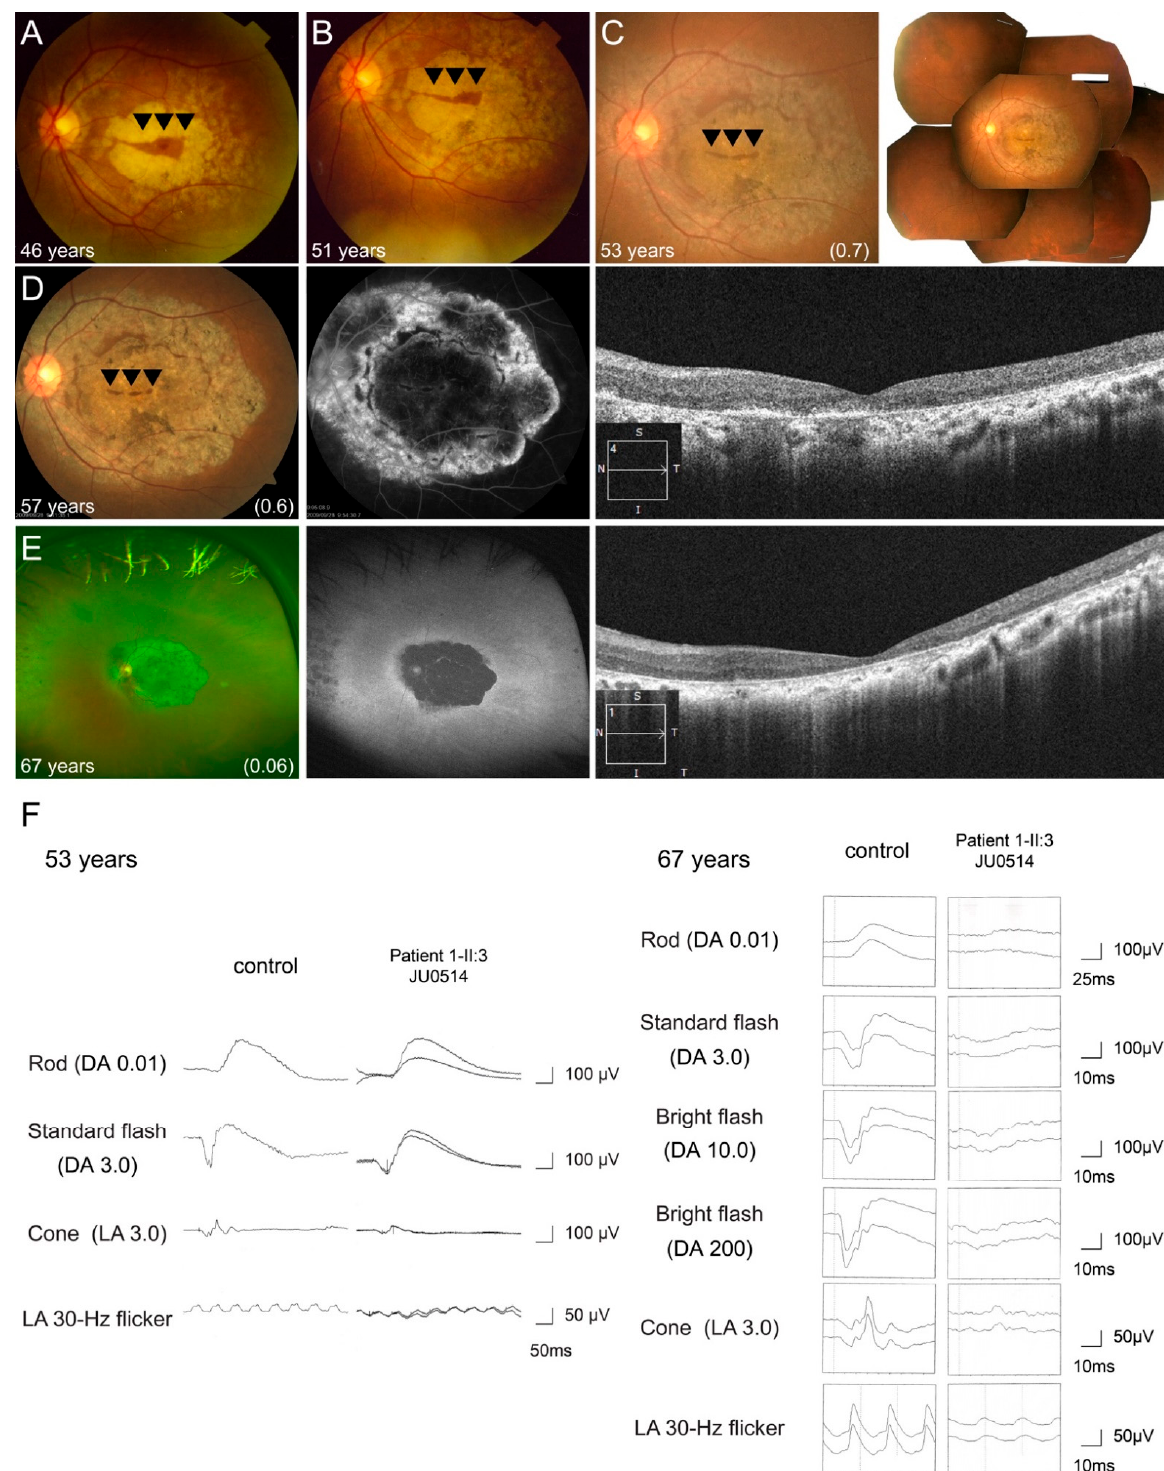
Figure 6. Longitudinal findings of a patient (Family 17-II:3 JU0514) with autosomal recessive cone-rod dystrophy. Multi- modal retinal imaging findings of the left eye are shown at ages of 46, 51, 53, 57, and 67 years. Fundus photography shows